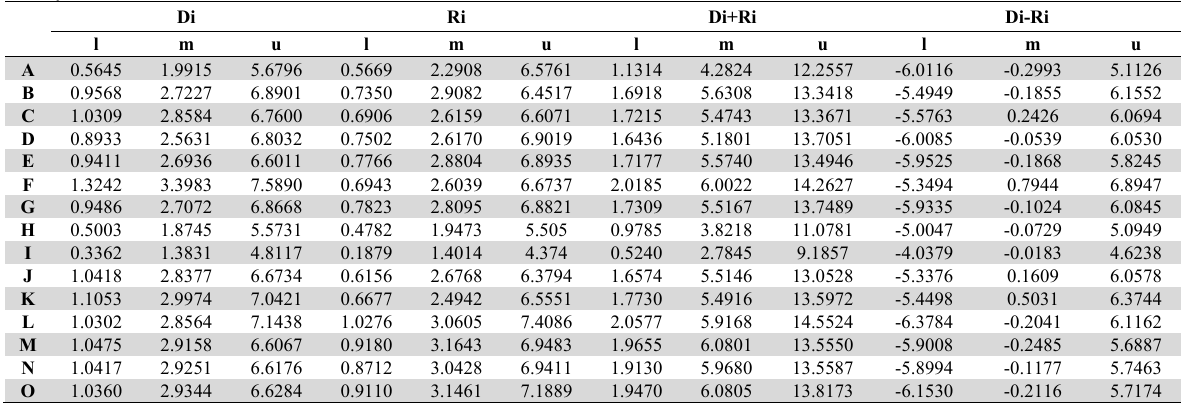
Fuzzy values of Di, Ri, Di+Ri,